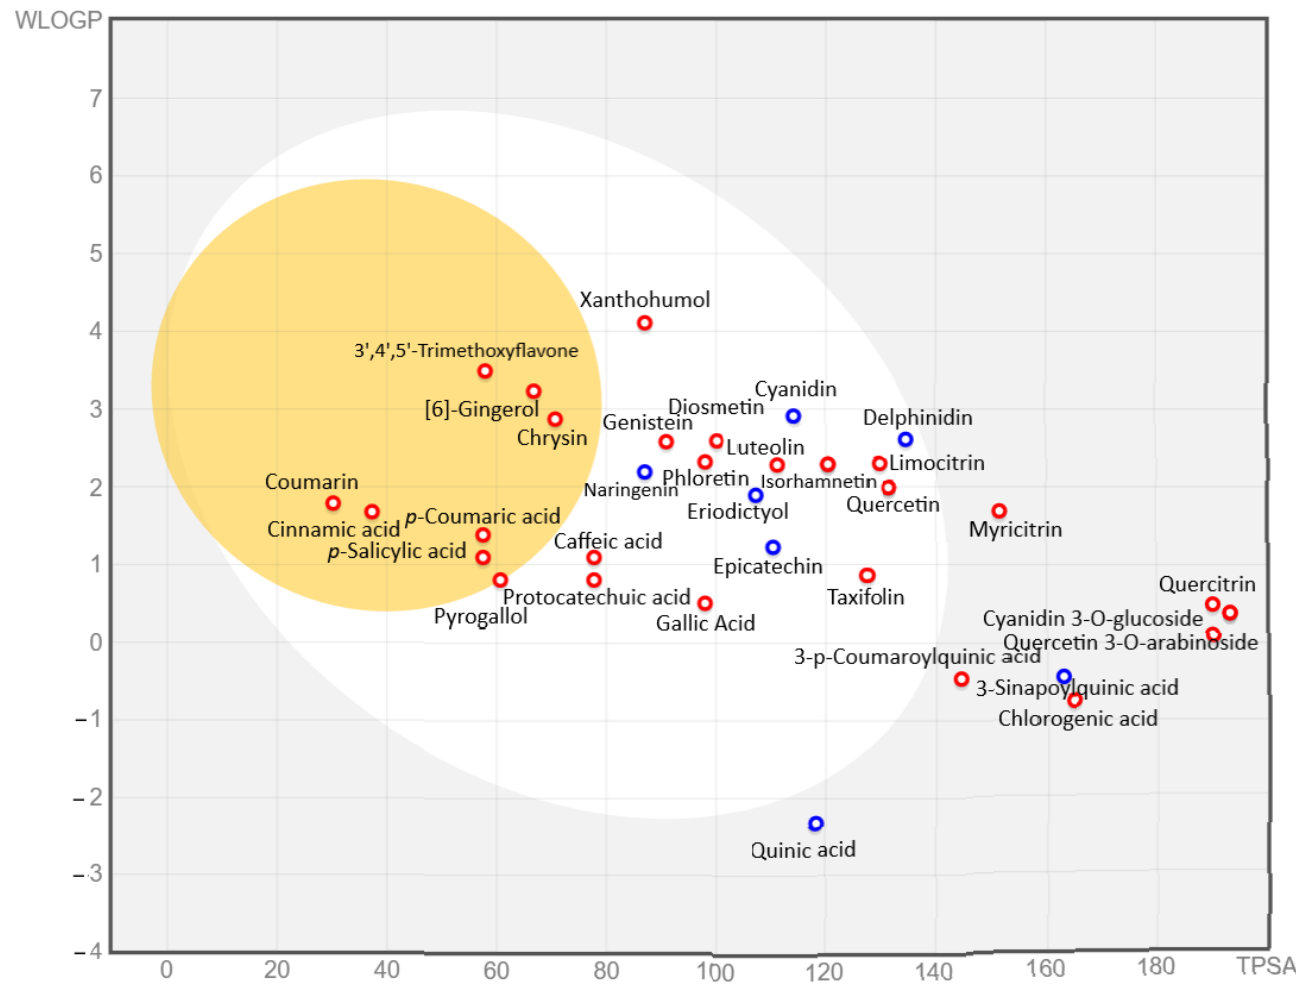
Figure 5. Evaluation of abundant phenolic compounds through the BOILED-Egg method. The blue dots indicate molecules predicted to be expelled from the CNS by P-glycoprotein, and the red dots indicate molecules predicted not to be expelled from the CNS by P-glycoprotein. The egg-yolk area predicts the phenolic metabolites that will passively penetrate the blood–brain barrier. In contrast, the egg-white area predicts which phenolic compounds will be absorbed through the gastrointestinal tract.